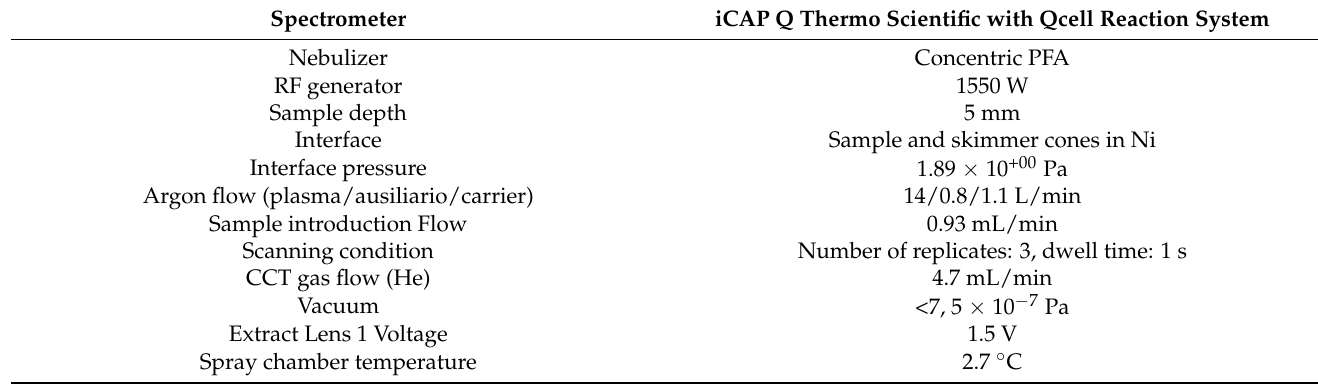
Table 2. Conditions of